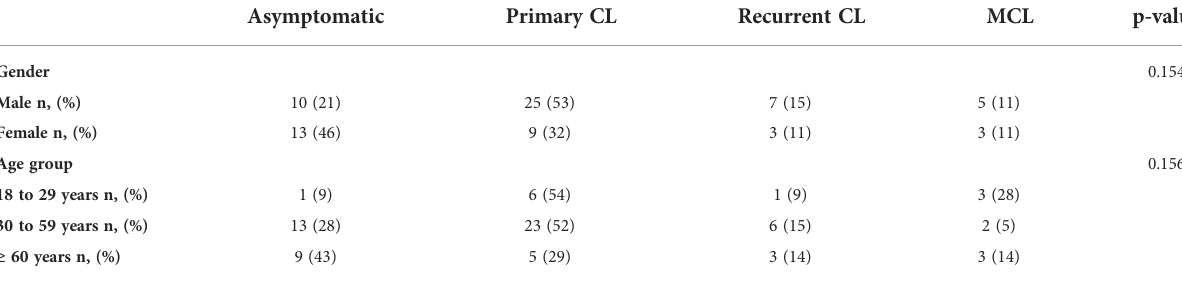
TABLE 1 Distribution of patients by age, sex, and clinical